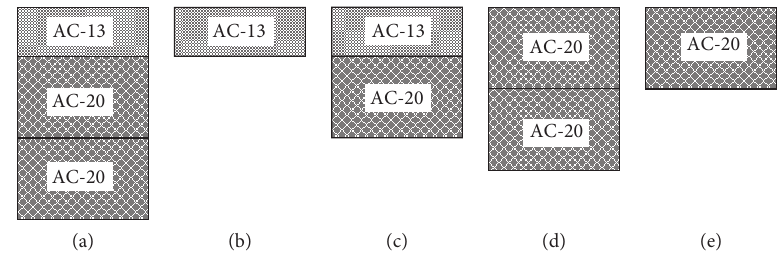
Figure 2: Specimen composition. (a) Pavement. (b) T (top AC layer). (c) TM (top and middle AC layers). (d) MB (middle and bottom AC layers). (e) M (middle AC layer) and B (bottom AC